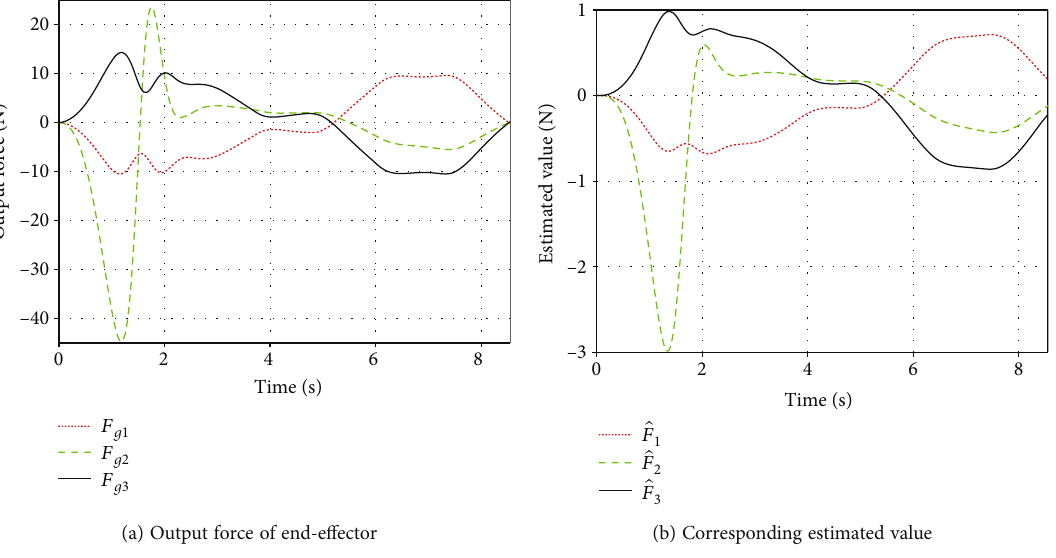
Figure 12: Output force of end-e ff ector of robust fuzzy sliding mode controller.